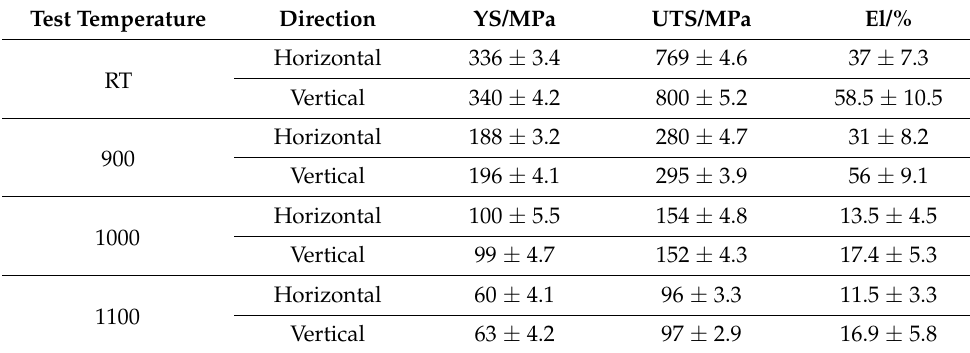
Table 2. The tensile properties of Haynes 230.